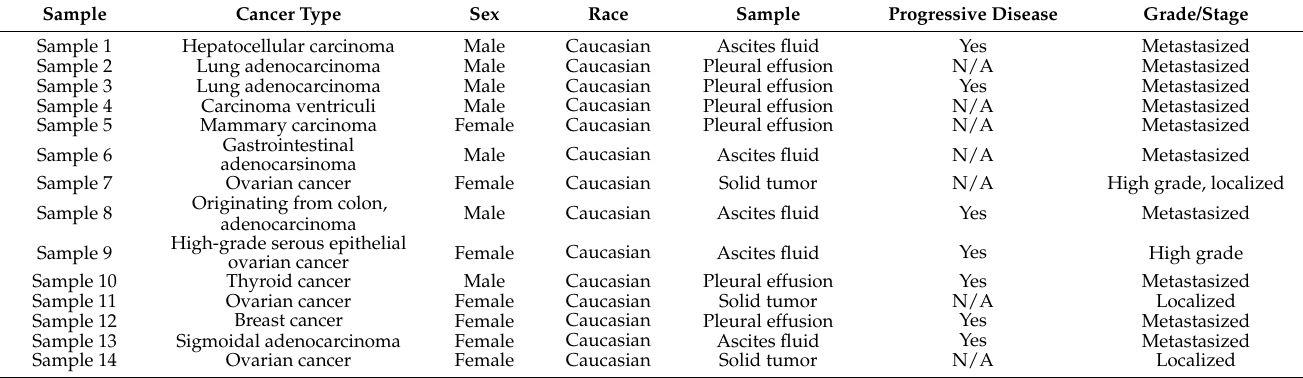
Table 3. Primary tumor samples and available information. N/A = not available or